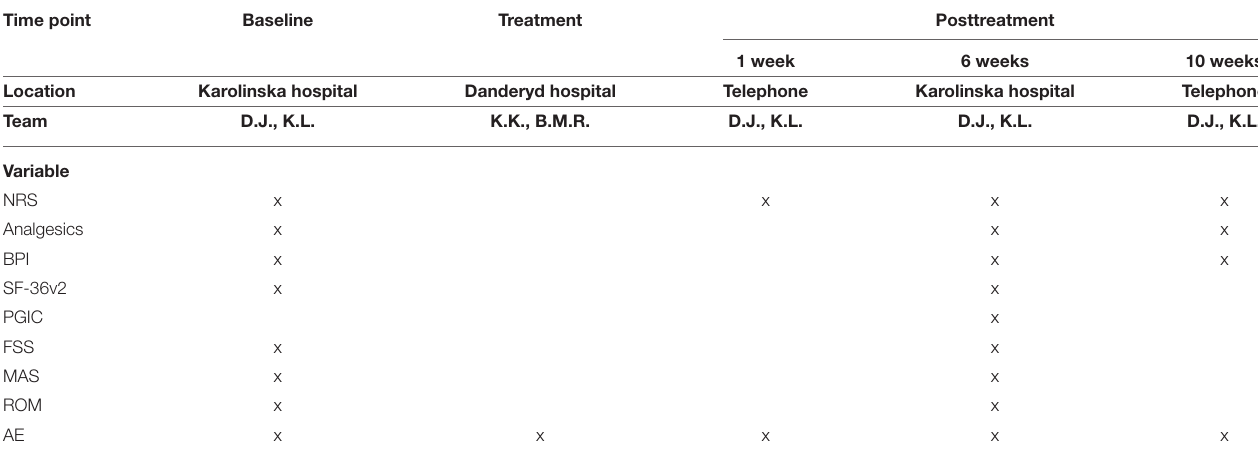
TABLE 1 | Overview of study time points.